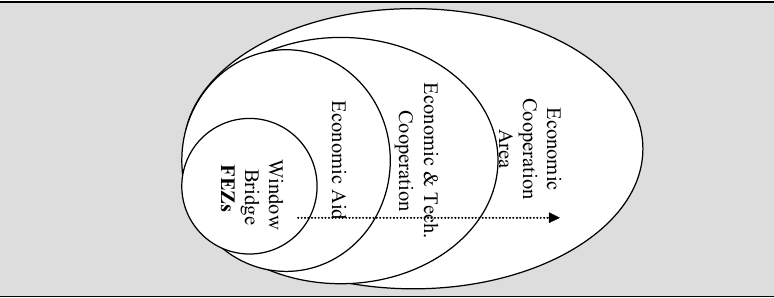
Fig. 1: The Models of FEZ’s Promotion to the Regional Economic Development